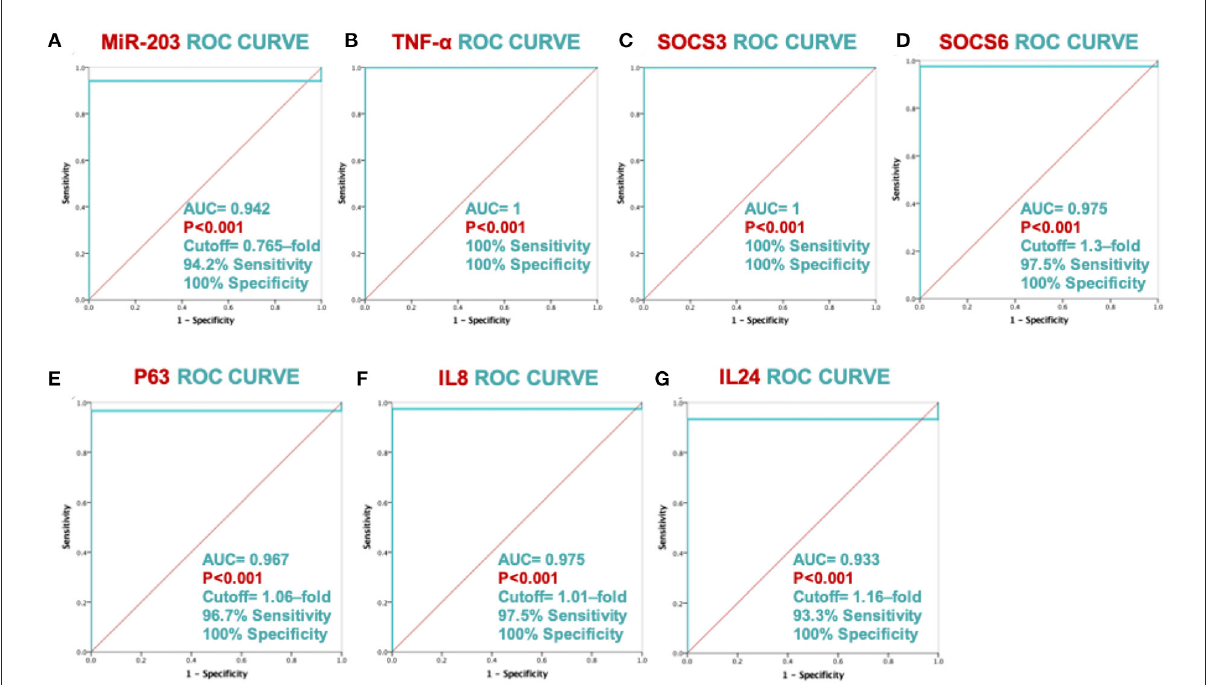
FIGURE2 ROC curve analysis’s ability to discriminate between MiR-203 and its target genes. The ROC curve with AUC and SE is displayed for each biomarker in graphs (A–G) .